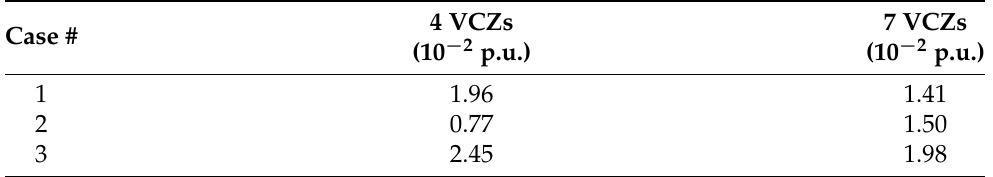
Table 9. Voltage performance index for the partitioning in four VCZs and seven VCZs provided by Decentralized APP